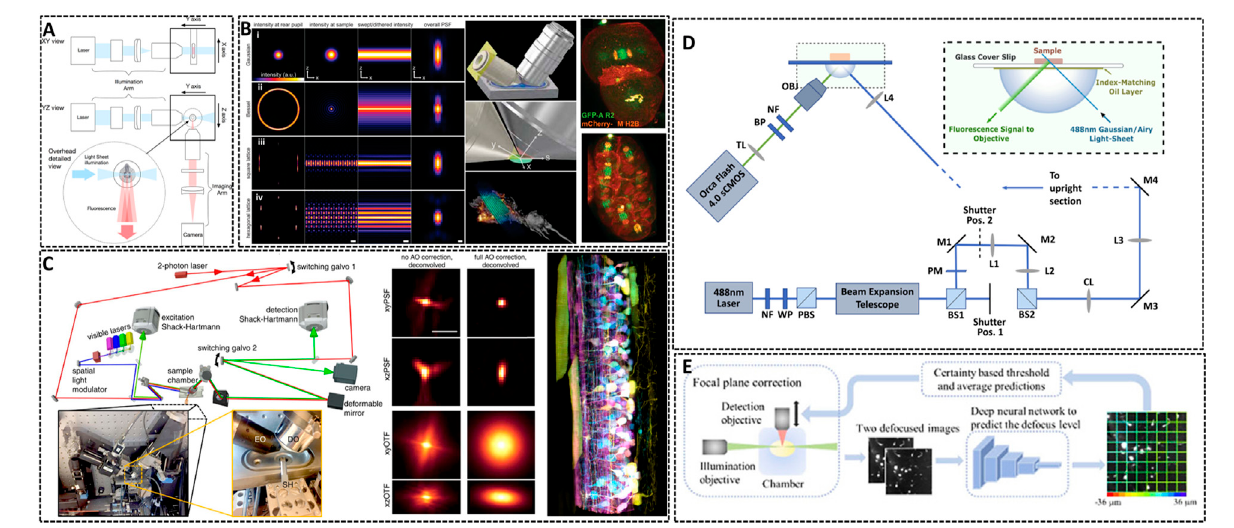
FIGURE4| Latticelight-sheetmicroscopyfor invivo imaging. (A) Basicworkingprincipleforlight-sheetmicroscopymethod(GirkinandCarvalho,2018).Theexcitationlight sheet is generated using a cylindrical lens before the excitation objective and the orthogonal imaging arm. Reprinted from Girkin and Carvalho, (2018) with permission from IOP Publishing. (B) Left:methodsshowingthetraditionalapproach(Gaussianbeam,i),Besselbeam(ii),andsquare(iii)andhexagonallattice(iv)usedforlightsheetmicroscopy(Chen B.-C.etal.,2014).Middle:schemeillustratingthecoreoflightsheetmicroscopy.Right:distributionofchromosomalpassengerproteinGFP-AIR-2(green)relativetoplasma membranesandhistones(red)inC.elegansembryosatthetwo-cellstageandthesix-cellstage.ReprintedfromChenetal.(2014)withpermissionfromAmericanAssociationfor theAdvancementofScience. (C) Left:simpli fi edmicroscopeschematicofadaptiveopticallatticelight-sheetmicroscopy(AO-LLSM)(Liuetal.,2018).Midddle:maximumintensity projections (MIPs) and corresponding optical transfer function (OTFs) of the uncorrected and fully corrected bead images. Scale bar, 1 μ m. Right: image of the spinal cord of a zebra fi shembryo58 hpf.ReprintedfromLiuetal.(2018)withpermissionfromAmericanAssociationfortheAdvancementofScience. (D) SchematicofthesetupofLSMusingan Airy beam (Corsettietal., 2020). Reprinted from Corsettietal. (2020) with permission from OpticalSociety ofAmerica. (E) Overview oftheintegration ofthedeep learning-based autofocus method with a custom-built LSM (Li et al., 2021). Reprinted from Li et al. (2021) with permission from Optical Society of